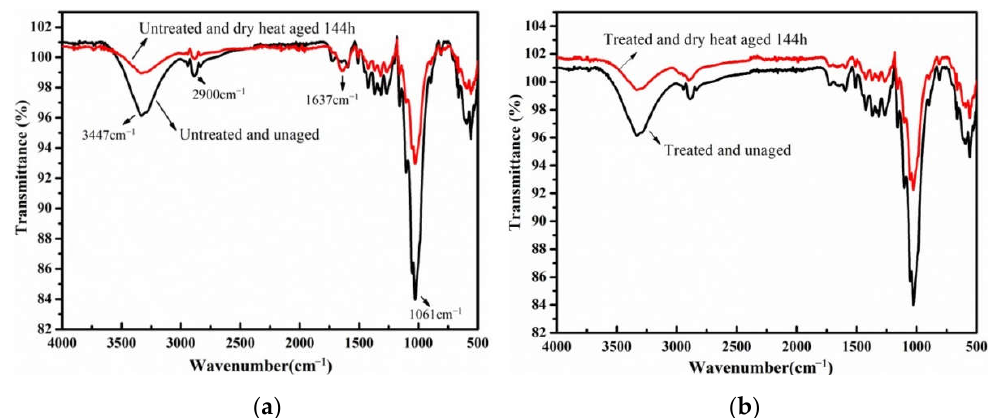
Figure 6. The IR spectra of paper-based documents before and after dry-heat aging: untreated ( a ) and treated ( b ).